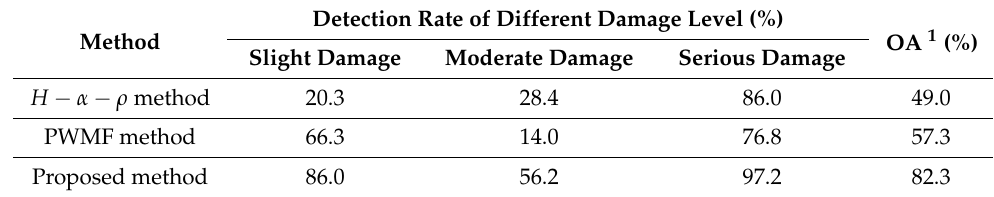
Figure 29. Block-level reference map and damage maps in Yushu: ( a ) reference map; ( b ) damage map from the H − α − ρ method; ( c ) damage map from the PWMF method; ( d ) damage map from the proposed method. Table 7. Accuracy evaluation results of damage maps from different methods in the Yushu study